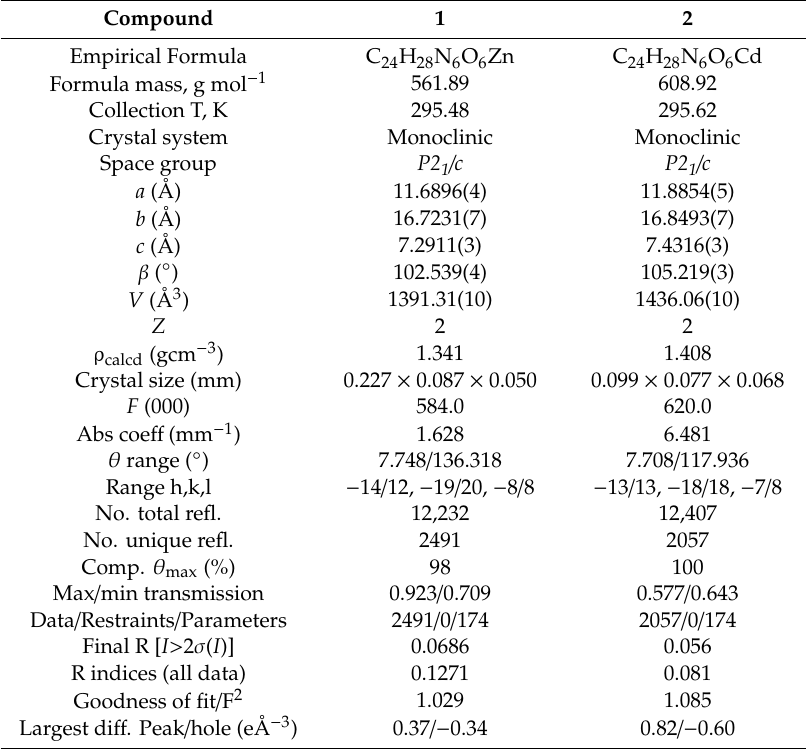
Table 1. Crystal data parameters for compounds 1 and 2